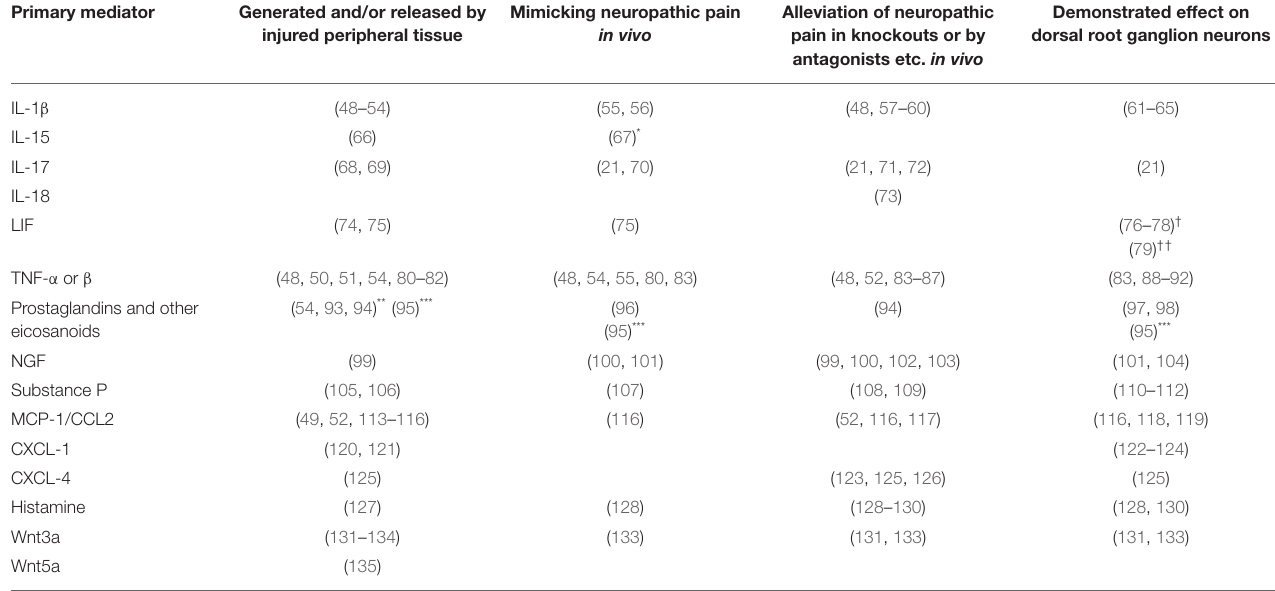
TABLE 1 | Primary mediators from site of nerve